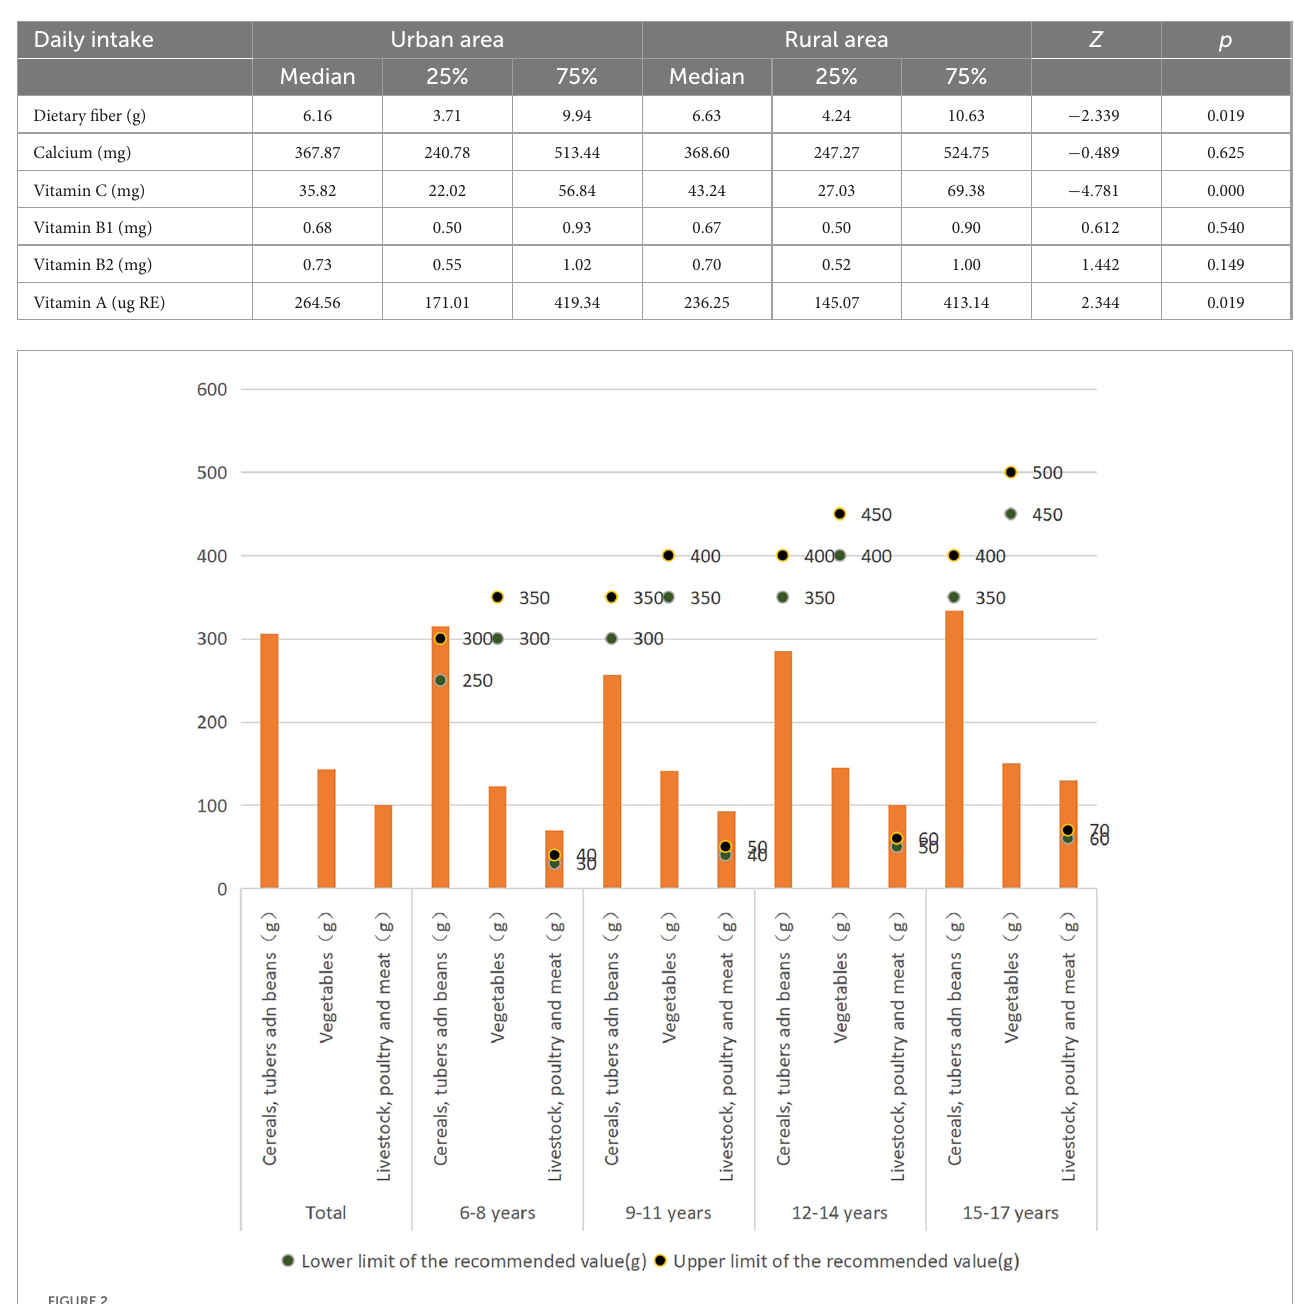
FIGURE2 Cereals, tubers and beans, vegetables and livestock, poultry and meat intake of rural children and